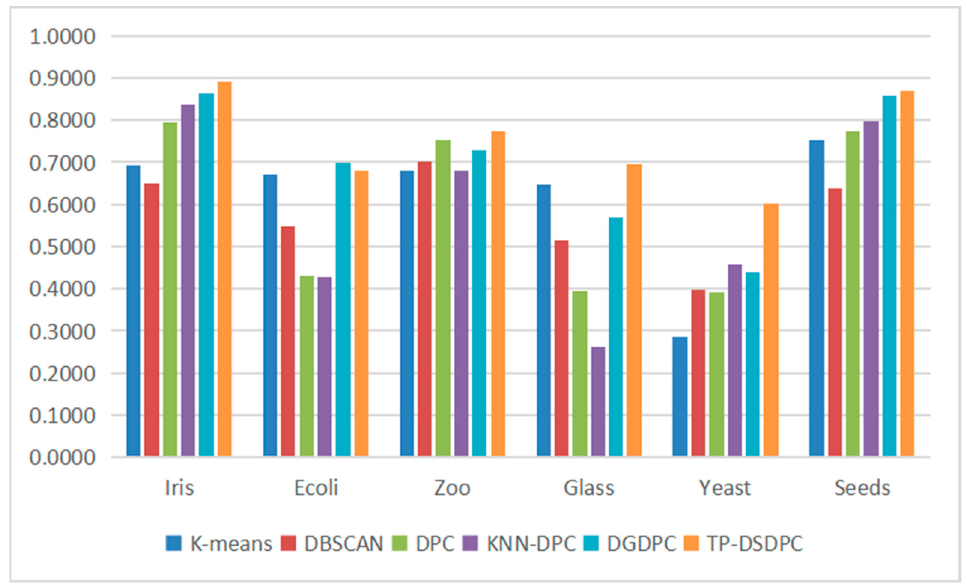
Figure 14. The ACC of the six algorithms on six real-world datasets.